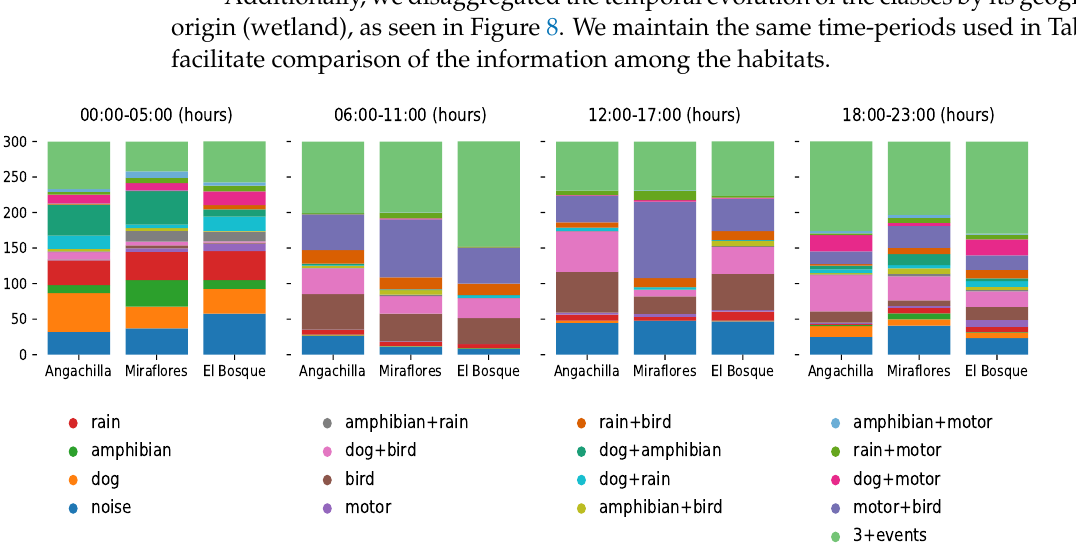
Figure 8. Average temporal evolution of sonic events present in each wetland, obtained from field